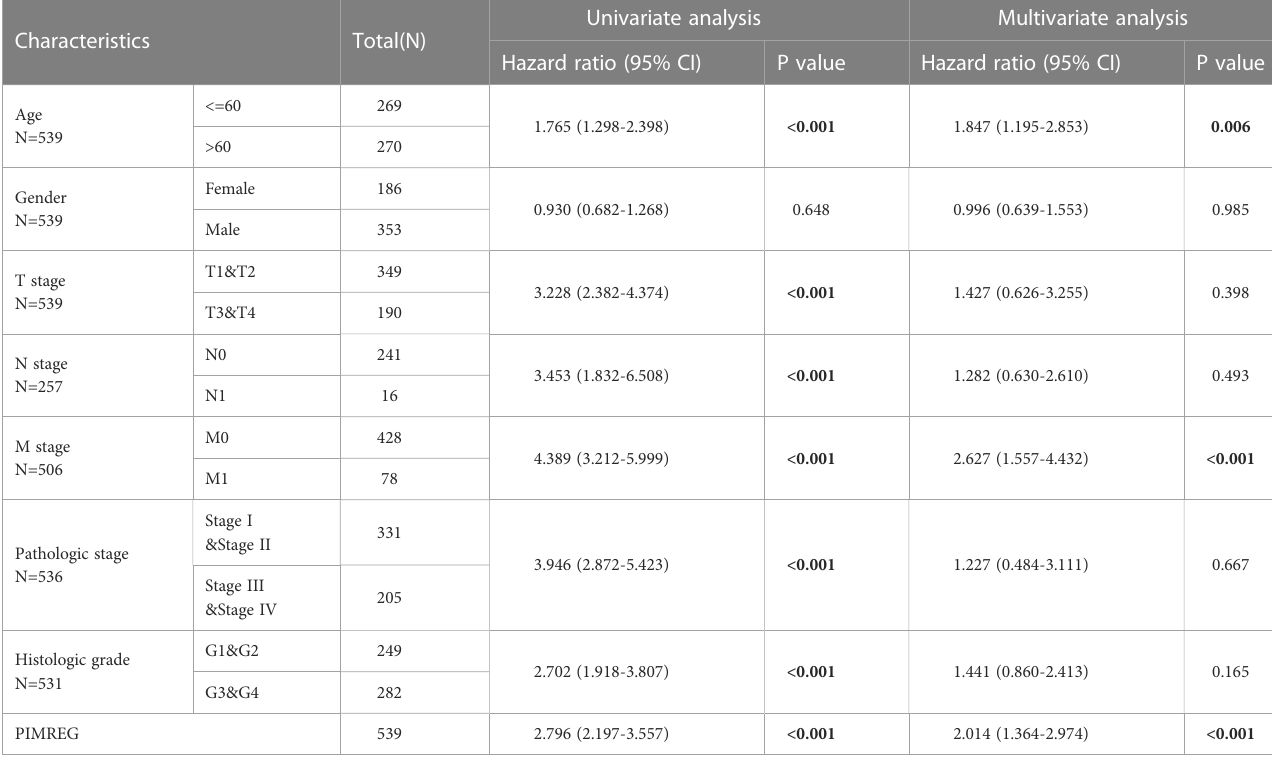
TABLE 3 Univariable and multivariable Cox regression analysis in PIMREG expression and clinical pathological characteristics of patients.